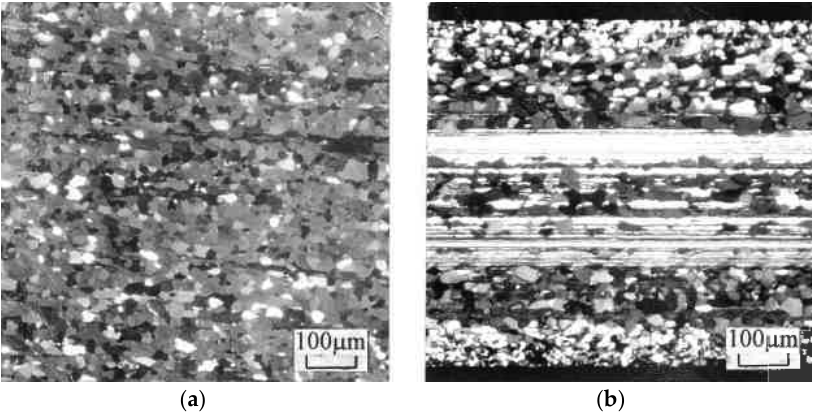
Figure 6. Microstructures of pure Al (99.9992%) after dynamic recrystallization induced by ECAE ( a ) and rolling ( b ) with effective strain of ε = 4.6. Materials 2018 , 11 , x FOR PEER REVIEW